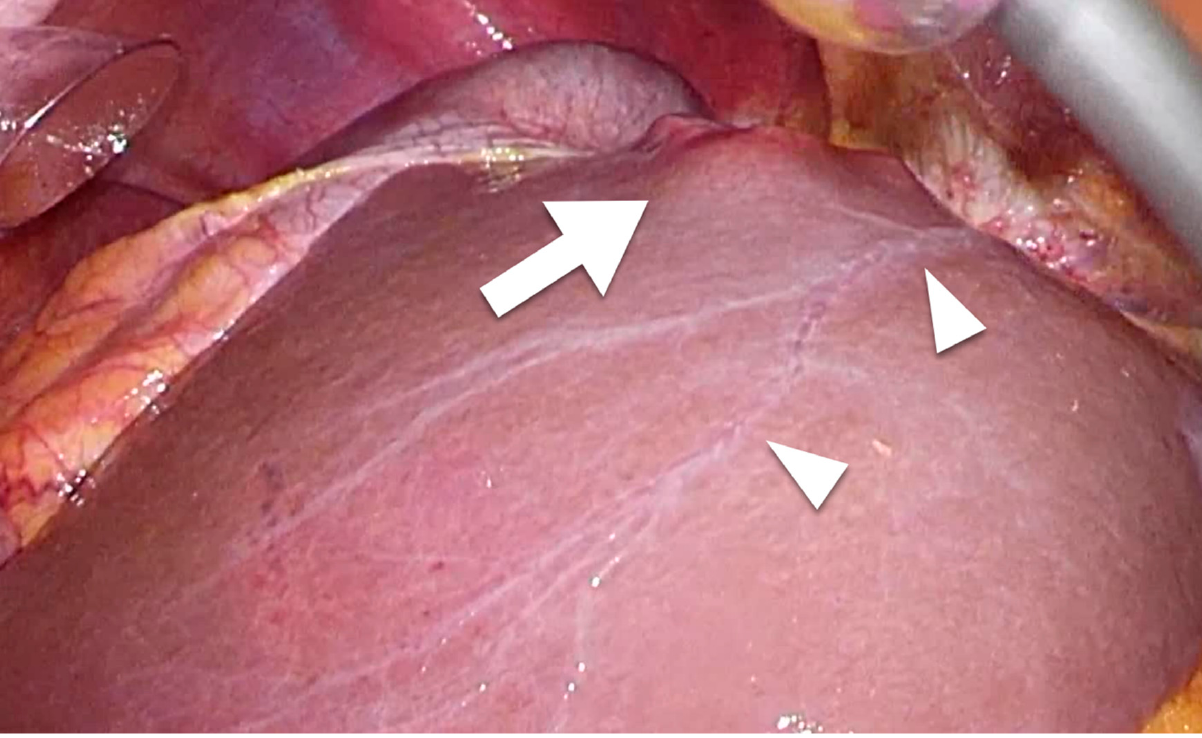
Figure 1. Laparoscopic findings of colorectal liver metastasis. Arrowheads show the capsular (superficial) lymphatic vessels. Tumor (arrow) that has invaded a lymphatic vessel can easily metastasize.